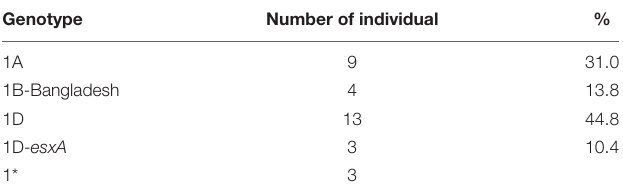
TABLE 1 | M. leprae genotypes identified in Bangladesh. Genotype Number of